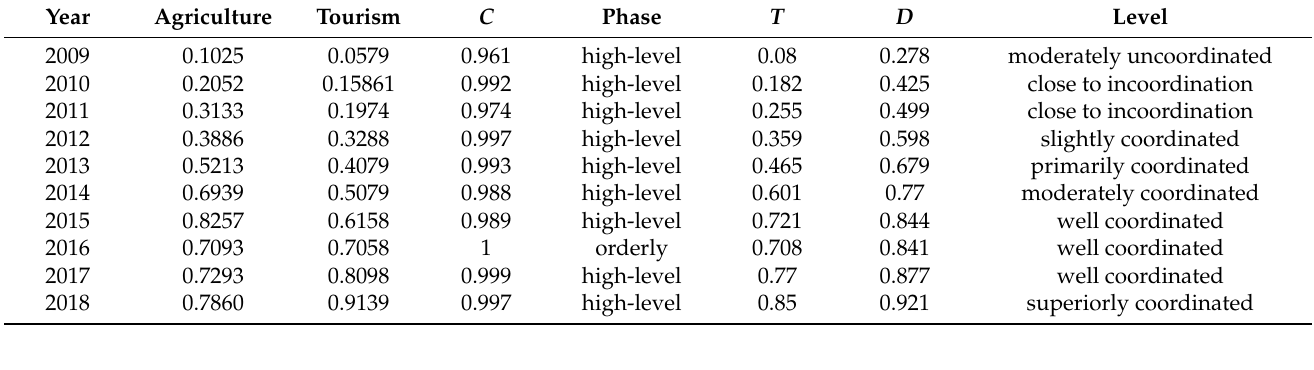
Table 4. Index of comprehensive development and coupling coordinative degree between the agriculture industry and the tourism industry.